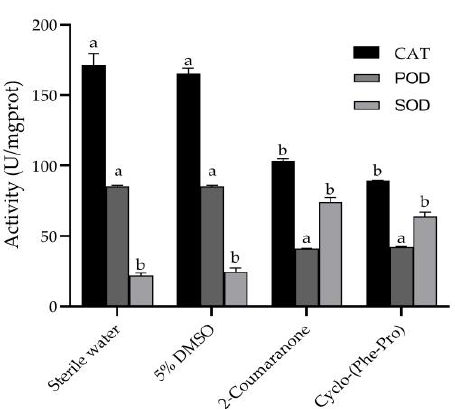
Figure 9. Activity of antioxidant enzymes of PWN. Means with the different superscript letters were significantly different at p < 0.05 according to LSD test.